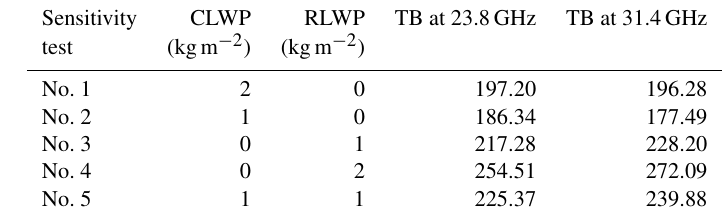
Table A1. Brightness temperatures (TB) at 23.8 and 31.4GHz for different assumptions of CLWP and RLWP values.